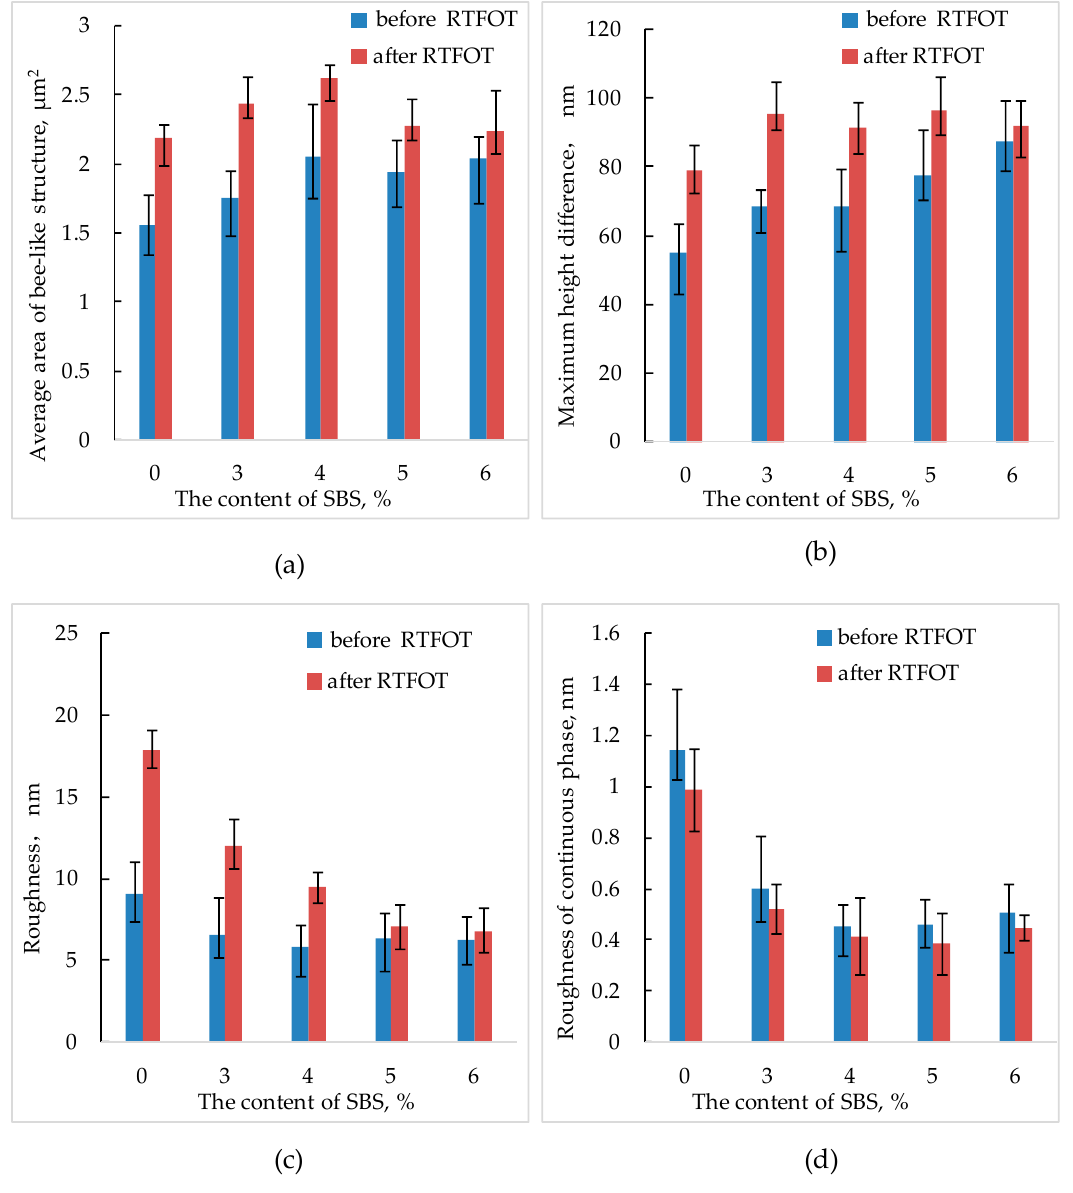
Figure 11. Comparison of the nano ‐ parameters of SBS modified bitumen before and after RTFOT under different SBS content (( a ) the average area of the bee ‐ like structure; ( b ) the maximum height difference; ( c ) roughness; ( d ) the roughness of continuous phase).